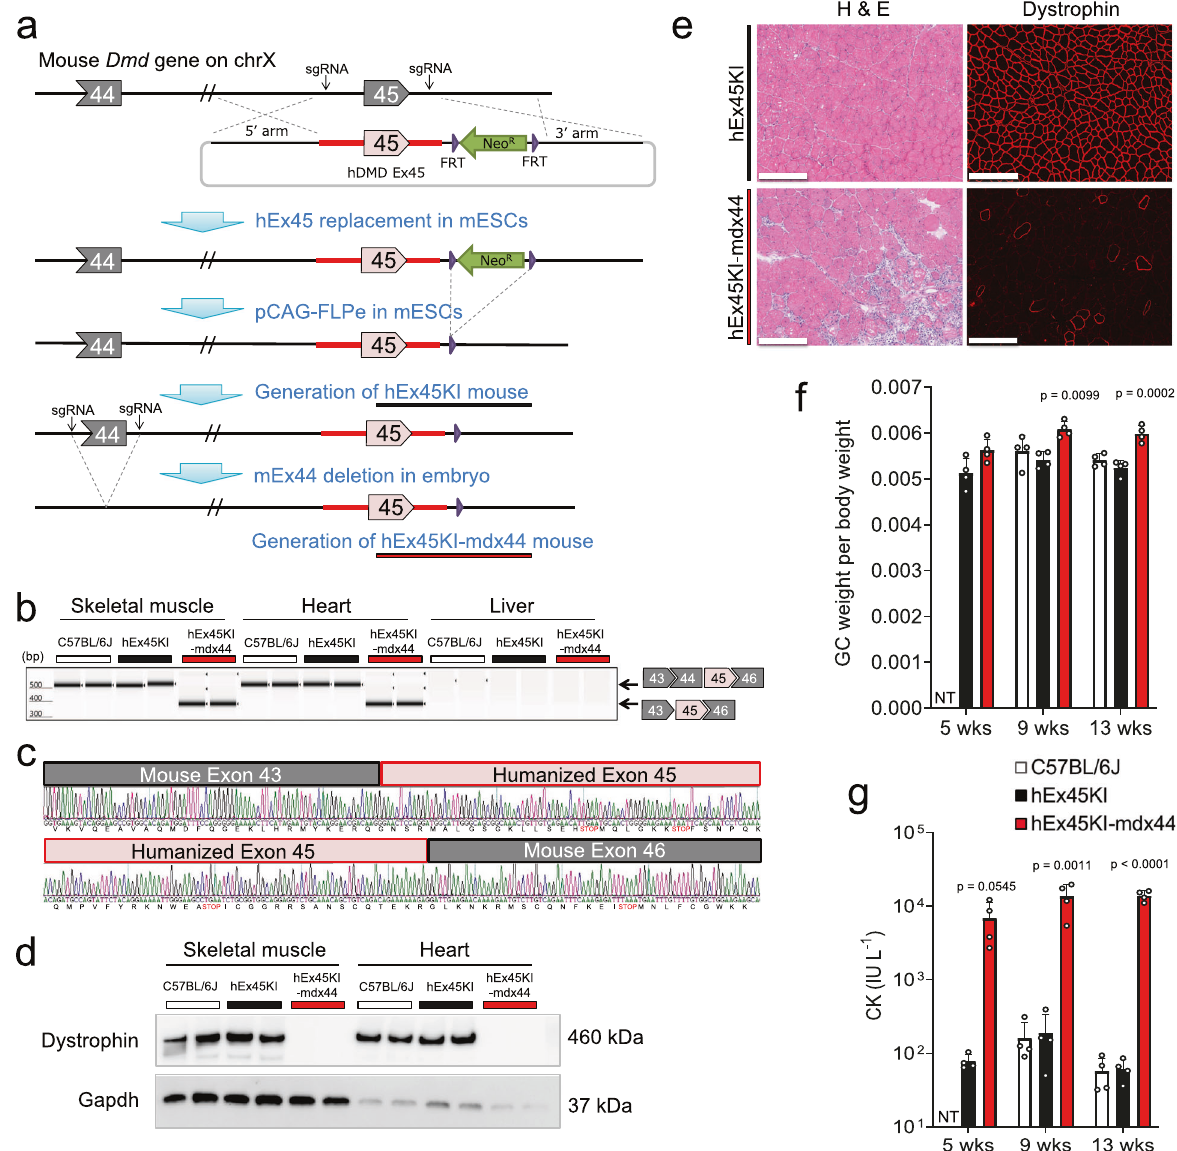
Fig. 3 Generation of an exon 45 humanized mouse model to assess sgRNAs that target human dystrophin. a Schematic illustration showing the generation of humanized DMD exon45 KI-Dmd exon44 knock-out mice (hEx45KI-mdx44). mESCs mouse embryonic stem cells. b Con fi rmation of exon 44 ( Δ Ex44) deletion was assessed by RT-PCR in GC, heart, and liver from C57BL/6J, humanized DMD exon45 KI (hEx45KI) or hEx45KI-mdx44 mice. Upper band shows normal transcript and lower band indicates Δ Ex44. n = 2 mice per each strain. Similar results were observed in more than 3 experiments. c The lower band from b was sequenced to con fi rm exon – exon junctions. The black line shows mouse Dmd , and red line shows humanized DMD sequences. d Lack of dystrophin protein expression in GC and heart were con fi rmed by Western blot analysis. n = 2 mice per each strain. Lack of dystrophin protein in hEx45KI- mdx44 mice was con fi rmed in more than 3 experiments. e Hematoxylin and eosin (H & E) staining and immunohistochemical staining of dystrophin in TA of hEx45KI (upper) and hEx45KI-mdx44 (lower) mice 9 weeks of age. n = 4 mice per each strain, but only a representative image from each strain is shown. Scale bars indicate 50 µ m. f , g GC weight per body weight (no unit) ( f ) or plasma creatine kinase (CK) level (IU L − 1 , international unit per liter) ( g ). White, black, and red columns show C57BL/6J, hEx45KI, and hEx45KI-mdx44 mice, respectively. NT not tested. Data are represented as means ±S.D. ( n = 4 mice). p values by two-sided Dunnett ’ s test showed signi fi cantly different from same-age hEx45KI